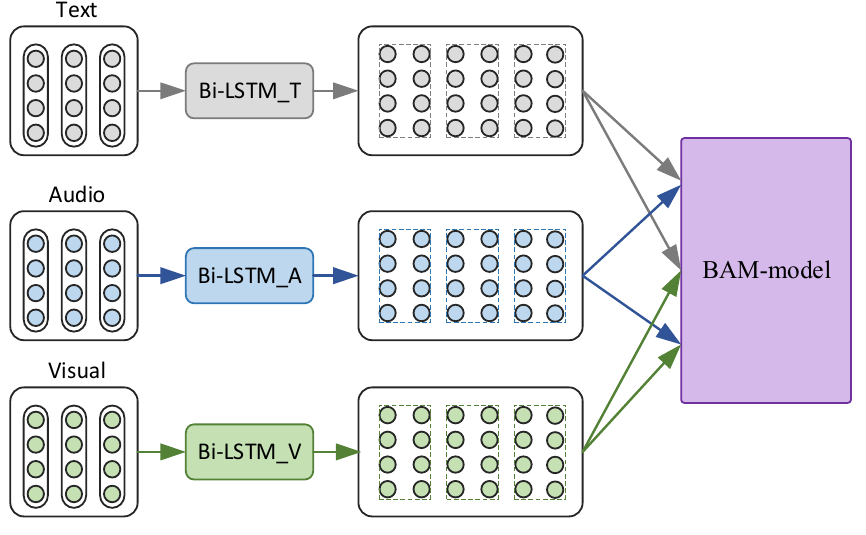
Figure 3. BAM-model. Figure 3.